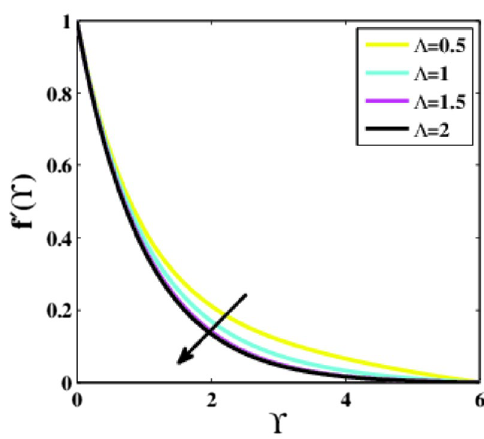
Figure 5. Plots of f